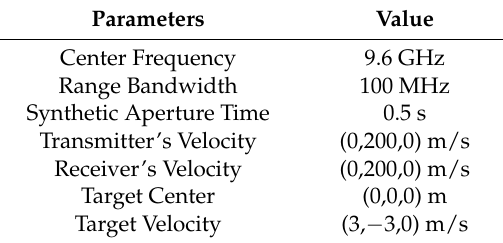
Table 1. Simulation parameters.